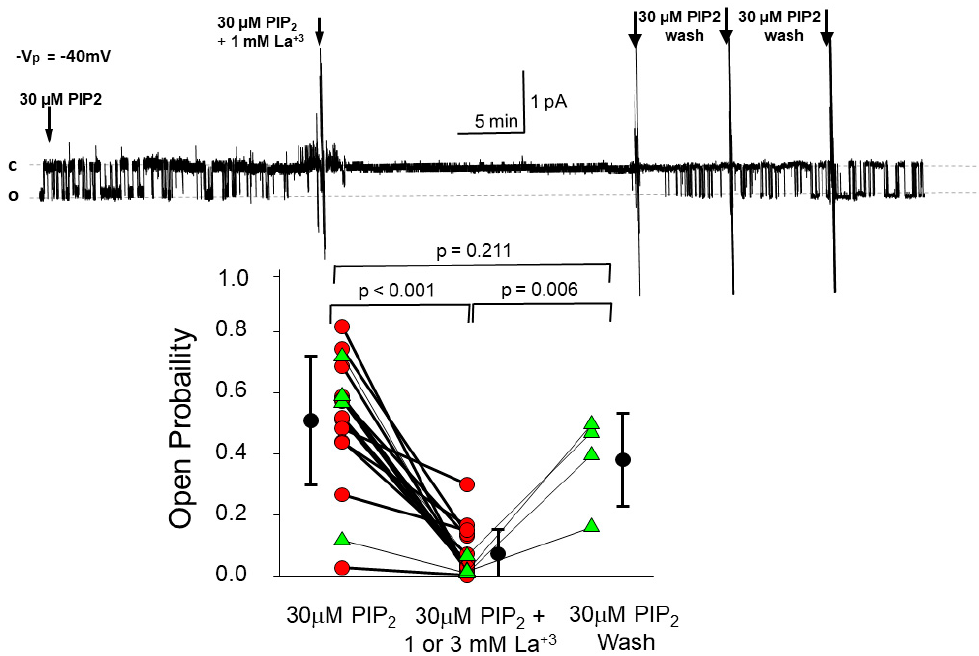
Figure 4. Lanthanum, a trivalent cation, reduces PIP 2 activity. We excised patches from H441 cells and added 30 µ M PIP 2 in PBS to the cytosolic surface to activate ENaC. After 12 min, we added 1 mM La 3+ Cl 3 − which rapidly reduced PIP 2 -induced ENaC activity. In four experiments, we washed away the La 3+ with PIP 2 -containing PBS, which rapidly reversed the reduction in ENaC activity. The P o of the channel before adding lanthanum is significantly different from after lanthanum ( p < 0.001) but is not different than after wash out ( p = 0.211); however, wash out is also significantly different from the lanthanum treated patch ( p = 0.006). (by repeated measures ANOVA).